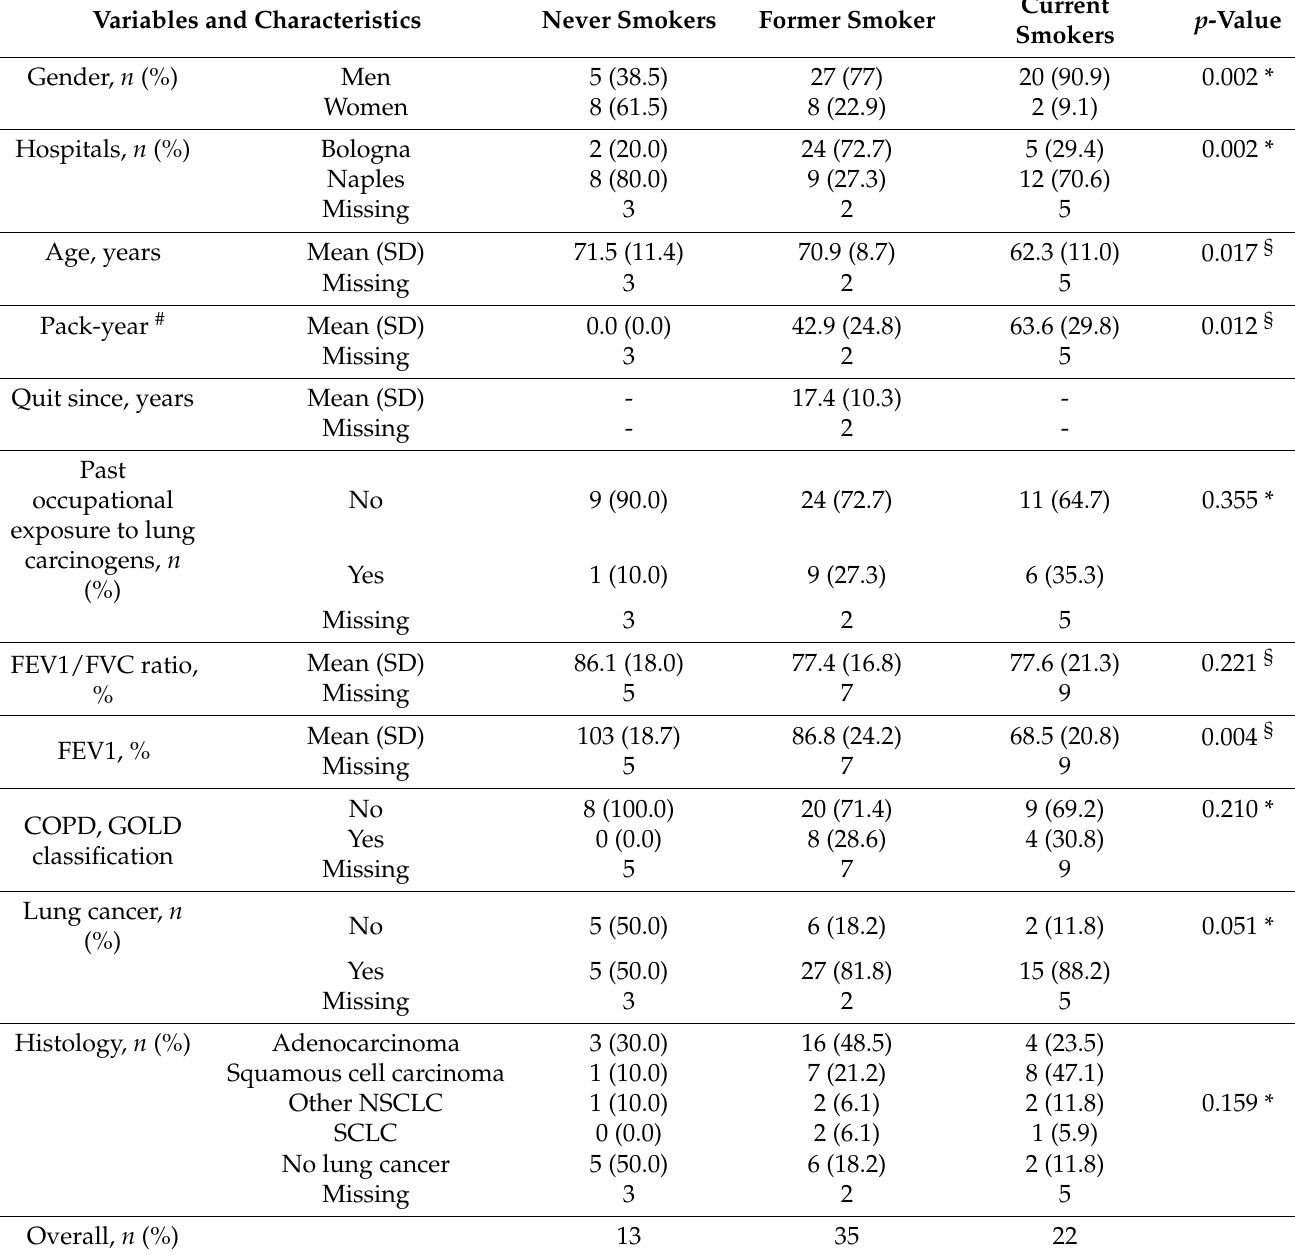
Table 1. Characteristics of patients participating in the “Polonium in vivo” study by smoking status ( n =